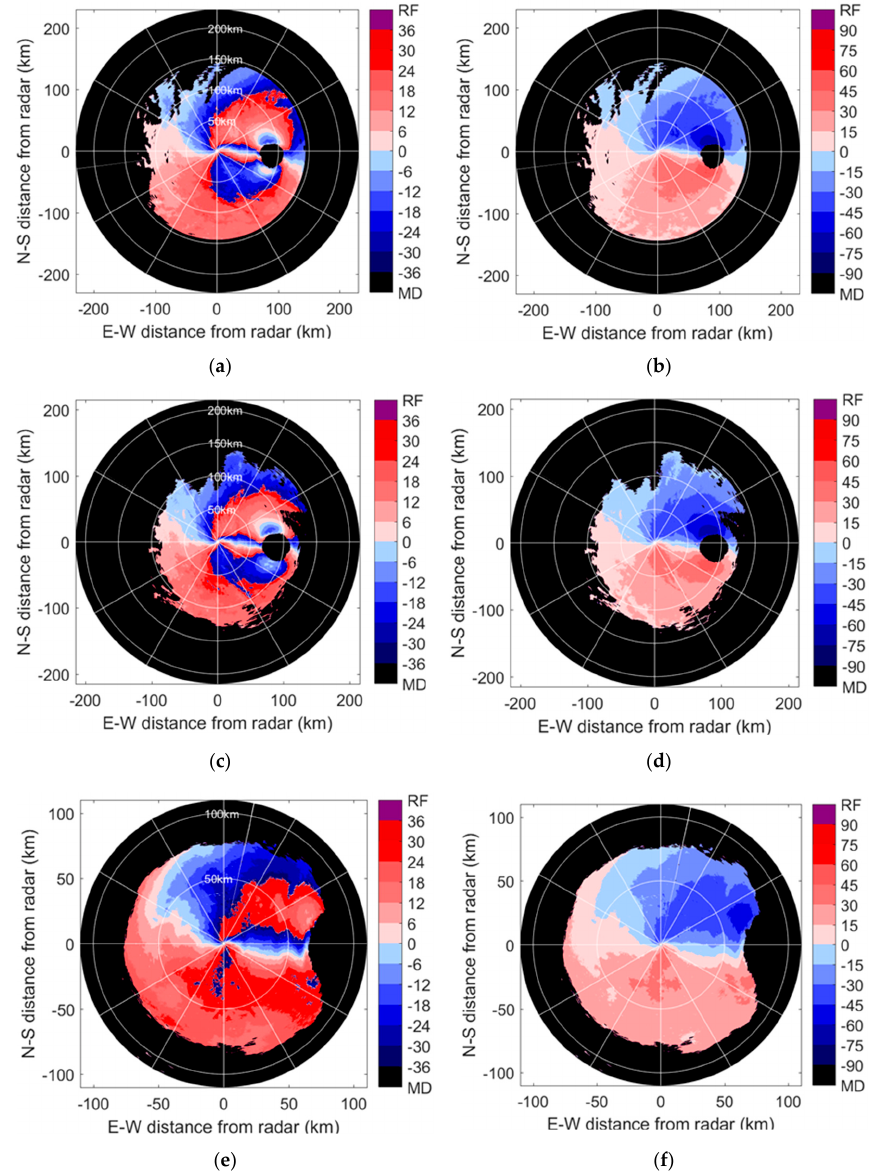
Figure 2. Radial velocity fields observed by Haikou radar station in the China radar network (CINRAD) system at 06:35 (UTC), 18 July 2014. ( a ) Original radial velocity at an elevation angle of 2.4°, ( b ) dealiasing result at an elevation angle of 2.4°, ( c ) original radial velocity at an elevation angle of 4.3 ◦ , ( d )dealiasingresult at an elevation angle of 4.3 ◦ , ( e ) original radial velocity at an elevation angle of 9.9 ◦ , and ( f ) dealiasing result at an elevation angle of 9.9 ◦ . The spatial scales of the pairs of images at different elevations are